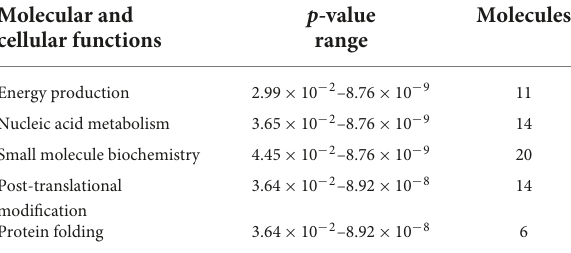
TABLE 2 List of molecular and cellular functions [derived from Ingenuity Pathway Analysis (IPA) analysis] associated with differentially expressed proteins in both experimental